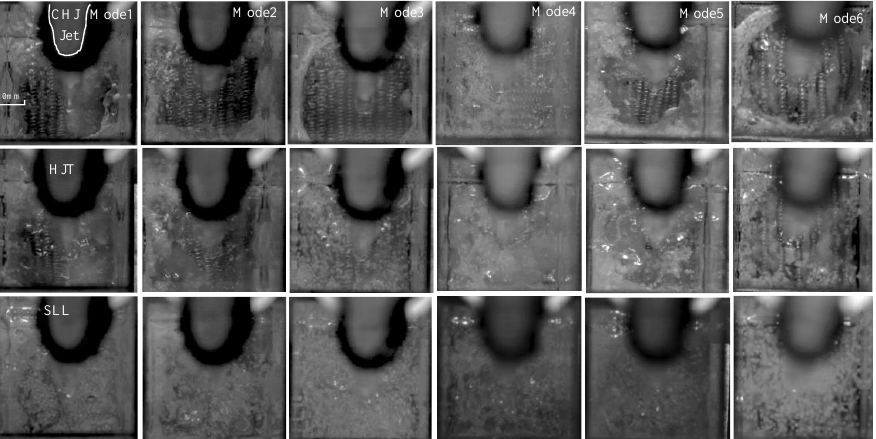
Figure 5. Hydraulic jump form and spring and particle arrangement in three physical forms of hydraulic jump of top view (casting speed of 2.4 m/min, mode 1–6). The flow field and hydraulic jump form at the high casting speed are similar to those